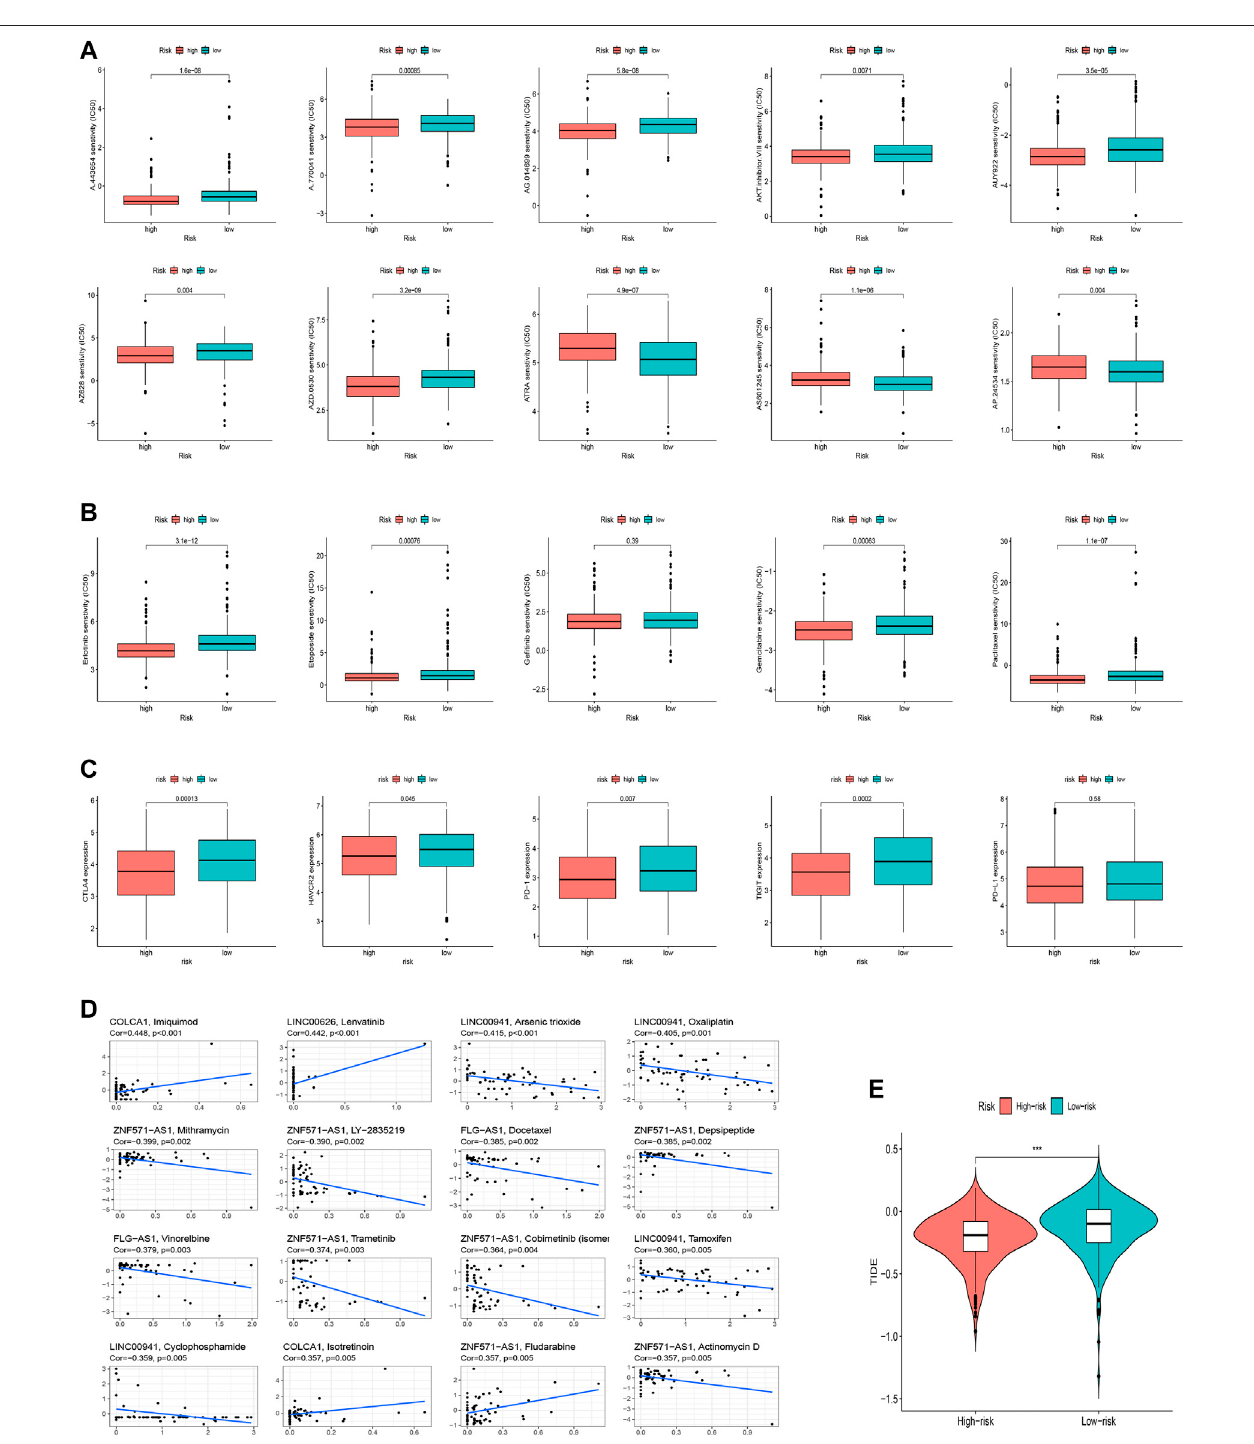
FIGURE 10 | Clinical application of the risk signature. (A) Comparison of IC 50 of chemotherapeutic drugs among two subgroups. (B) Investigation of anti-tumor drug sensitivity-targeting signature. (C) Expression levels of CTLA4, HAVCR2, PD-1, TIGIT, and PD-L1 in the high- and low-risk groups. (D) Correlation between 16 lncRNAs and chemotherapeutic drugs. (E) TIDE prediction difference in the high-risk and low-risk groups.